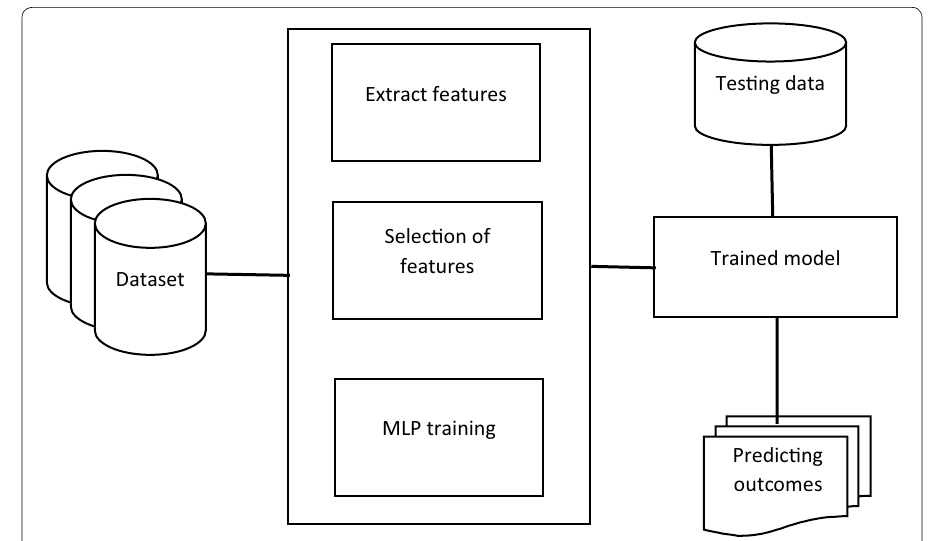
Fig. 2 Proposed architecture for analysing medical